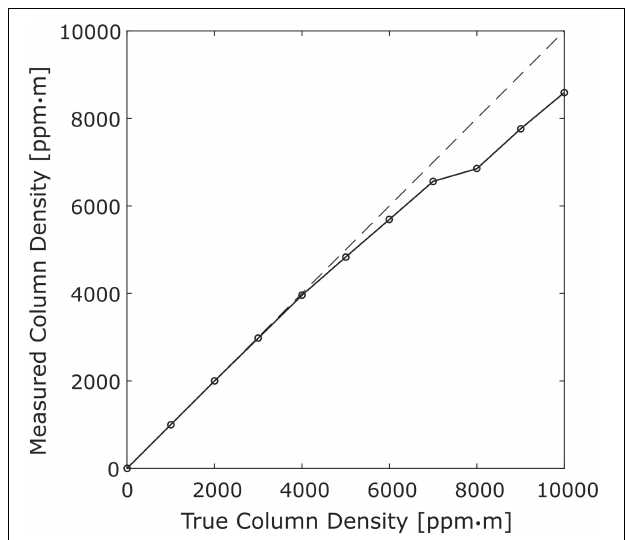
FIGURE 7 | Modeled PiSpec response to SO 2 in the fit window 314–324 nm. The response shows the saturation effect, whereby larger optical depths become non-linearly related to column densities, becomes significant above ≈ 4000 ppm · m. This model can be used to correct for retrieved column densities, or the DOAS fit window can be shifted to longer wavelengths to minimize the